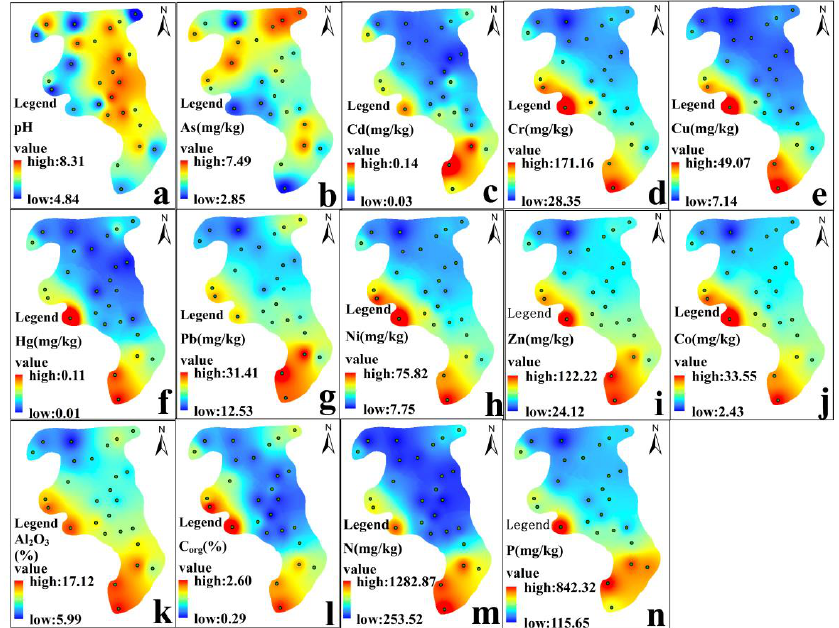
Figure 2. The overall spatial distribution of ( a , k – n )physico-chemical properties (pH, Al 2 O 3 , C org , N, P) and ( b – j ) heavy metals (As, Cd, Cr, Cu, Hg, Pb, Ni, Zn, Co) from 0–100 cm in the wetland sediment. The content of sand, silt, and clay ranged from 10.21% to 90.20%, 7.21% to 74.50%, and 2.60% to 20.30%, respectively; the mean ranking was silt (55.96%) > sand (32.56%) > clay (11.48%). The wetland sediments were mainly composed of silt and sand (Table 2, Figure 3).